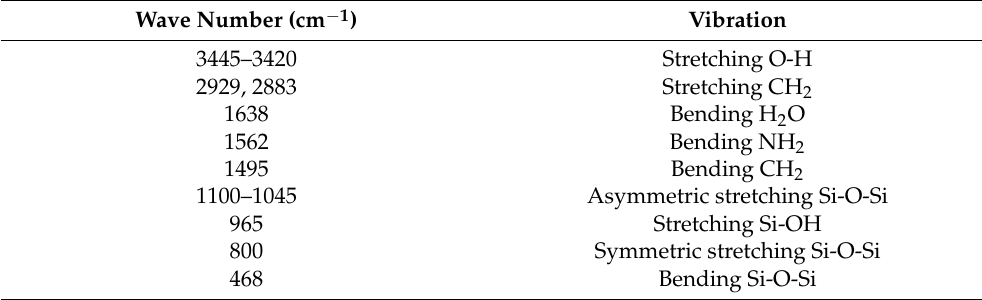
Table 2. FTIR bands of